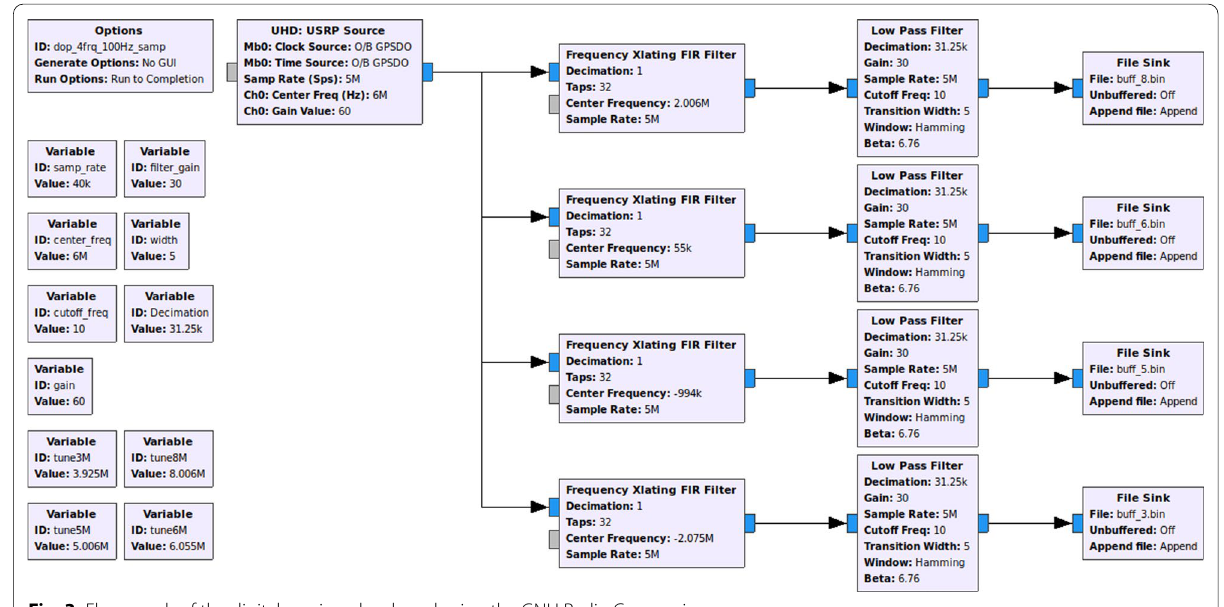
Fig. 3 Flow graph of the digital receiver developed using the GNU Radio Companion